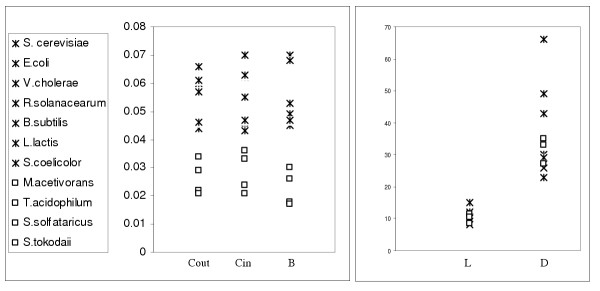
Five network indices (Clustering Coefficients (Cout, Cin), Betweenness (B), Average Path Length (L) and Diameter (D)) of the metabolic networks in the eleven organisms.